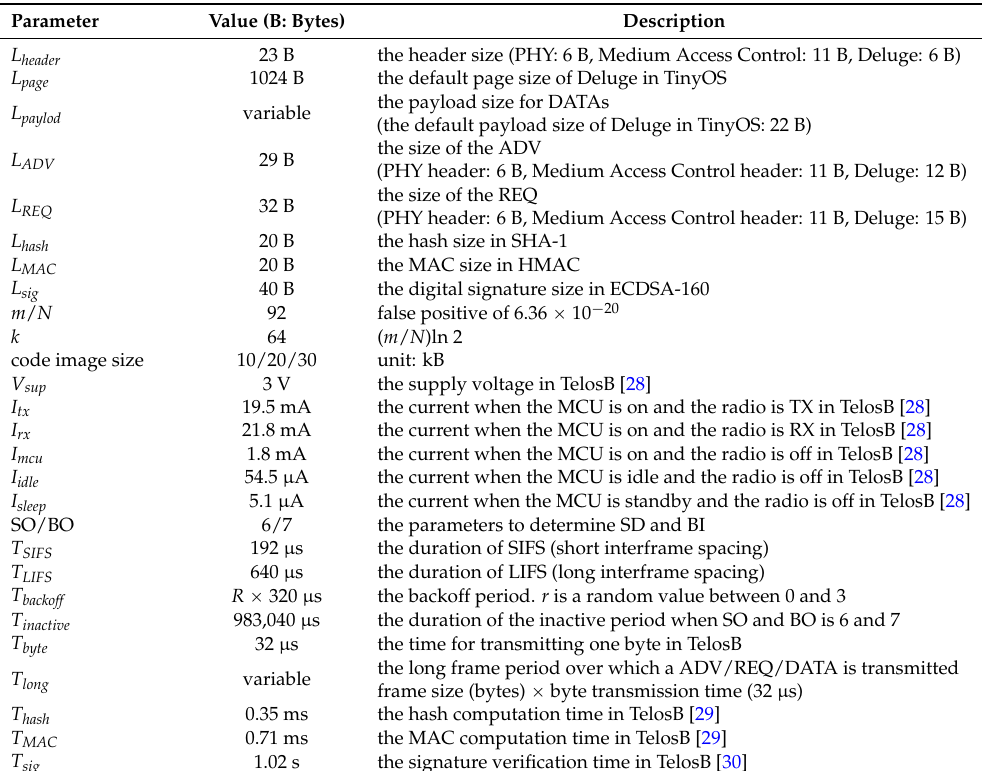
Table 1. Parameters for Performance